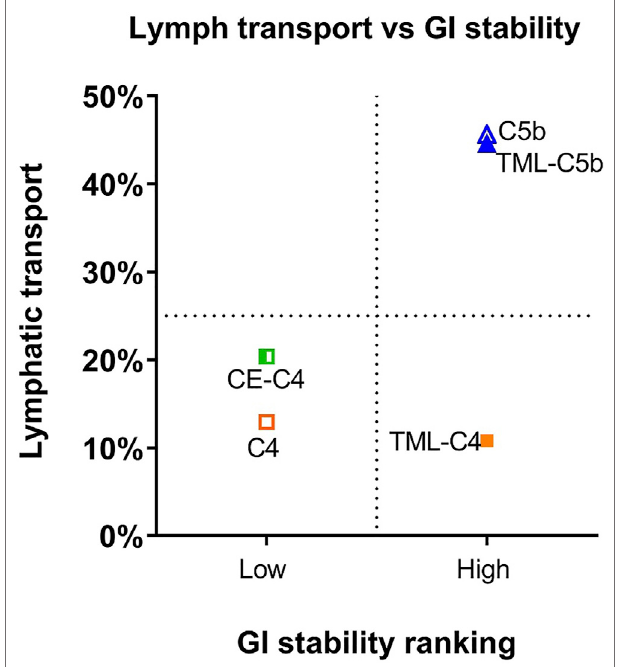
FIGURE 7 | Comparison of lymphatic transport and GI lumen stability of BUP prodrugs, where GI lumen stability of the MG intermediates is categorized as low (apparent half-life < 10 min) and high (apparent half-life > 1 h). GI stability ranking, rather than exact half-lives are used for x -axis because the rapid degradation of BUP-C4-MG and BUP-CE-C4-MG prevents accurate calculation of half-lives.